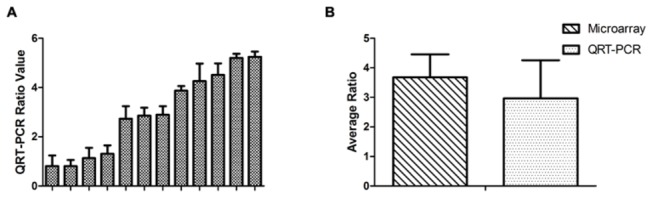
Comparison of the expression changes detected by oligonucleotide microarray and quantitative QRT-PCR analyses.The vertical numbers with log2 transformation are the pair-matched ratio of malignant lesions to premalignant lesions. A. The columns stand for the ratios derived from quantitative QRT- PCR experiment. B. Comparison of the ratios between microarray and quantitative QRT-PCR analyses.